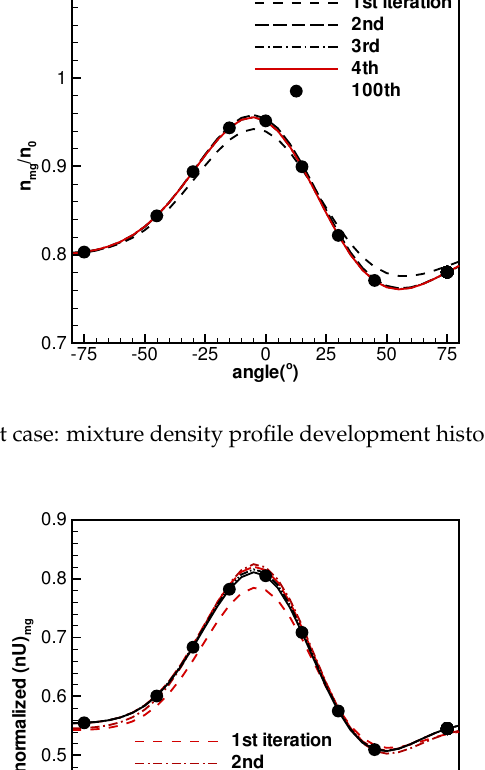
Figure 19. Test case: mixture number flux nU / ( n 0